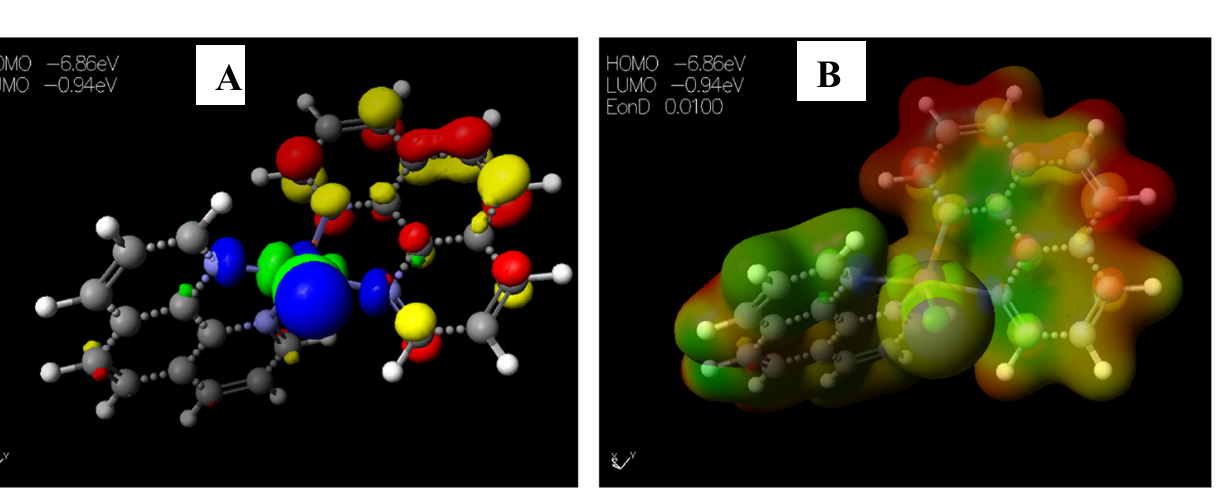
OO Figure 3. Plausible mechanism of Cu(II) photoredox catalysis. 2.2.4. FT-IR 1,10-Phenanthroline exhibited absorption bands in the regions of 1519–1643 ṽ (C=N) and 2095–3091 ṽ (C-H). While the corresponding copper(II) complex (Cat) showed absorp- tion bands at 3355 ṽ (OH), 3068 ṽ (CH), 2981 ṽ (CH), 2344 ṽ (CH), 1602 ṽ (C=N), 1428 ṽ (C=N), and 424 ṽ (Cu–N) (Figure S3). The presence of ṽ (OH) confirmed the presence of water in the coordination sphere of the complex. Numerous weak absorption bands were observed